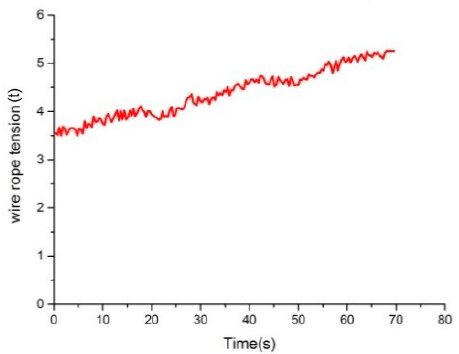
Figure 20. Data of acoustic filtering sensor.